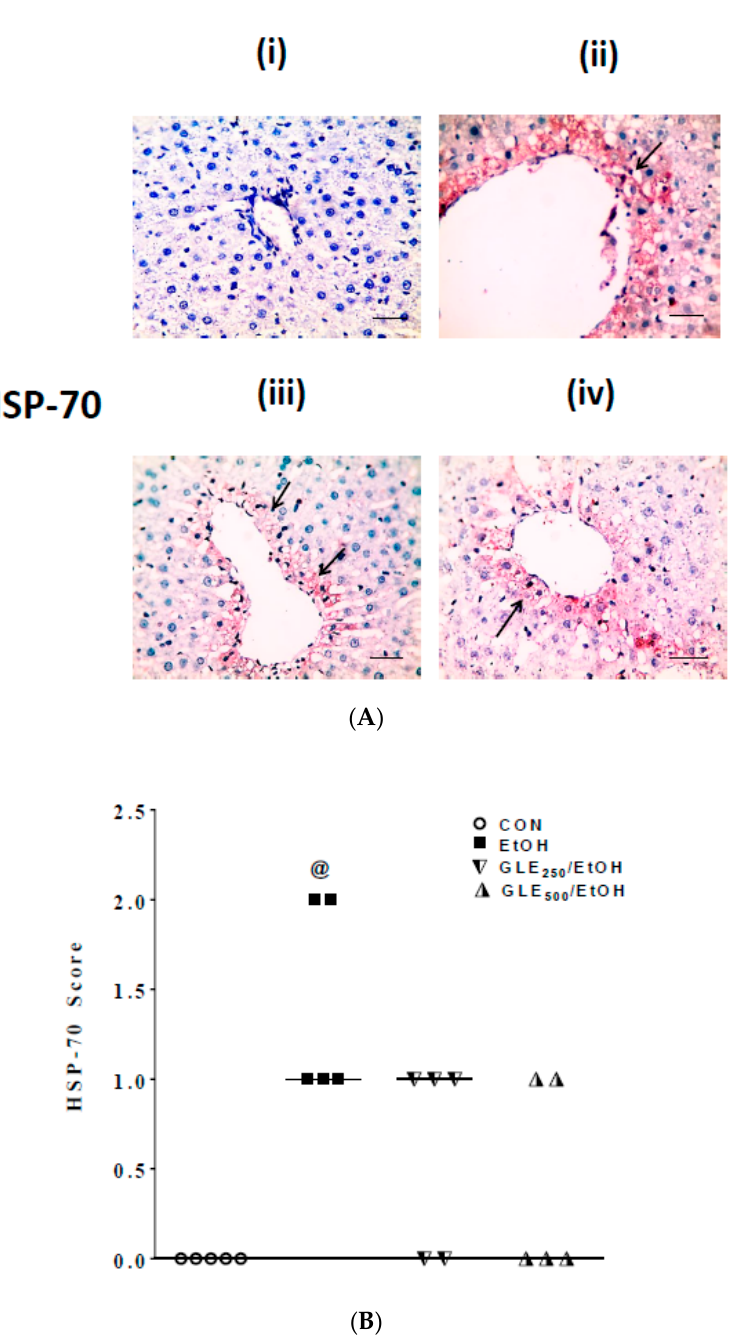
Figure 5. GLE effects on hepatic expression of HSP-70 in EtOH-treated rats. Representative photomicrographs of immunohistochemical detection of HSP-70 in livers from CON (i), EtOH (ii), GLE 250 /EtOH (iii) and GLE 500 /EtOH (iv) groups ( A ) and scatter-dot plot showing the score of HSP-70 (median is indicated by a line) in the same groups ( B ). @ p ≤ 0.05 compared with CON, using Kruskal–Wallis followed by Dunn’s Multiple Comparison test (n = 5). CON: control, EtOH: ethanol, GLE: grape leaf extract, HSP-70: heat shock protein-70.